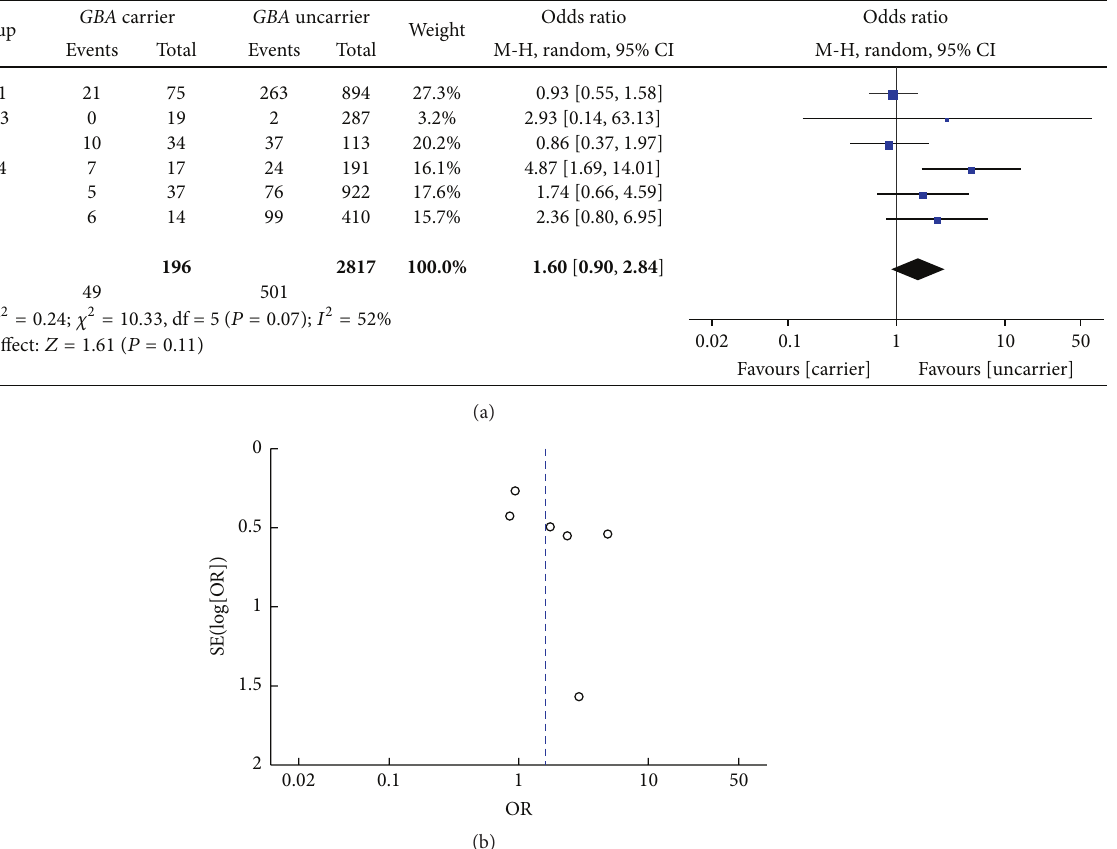
of H-Y between GBA + PD and GBA − PD was 0.06